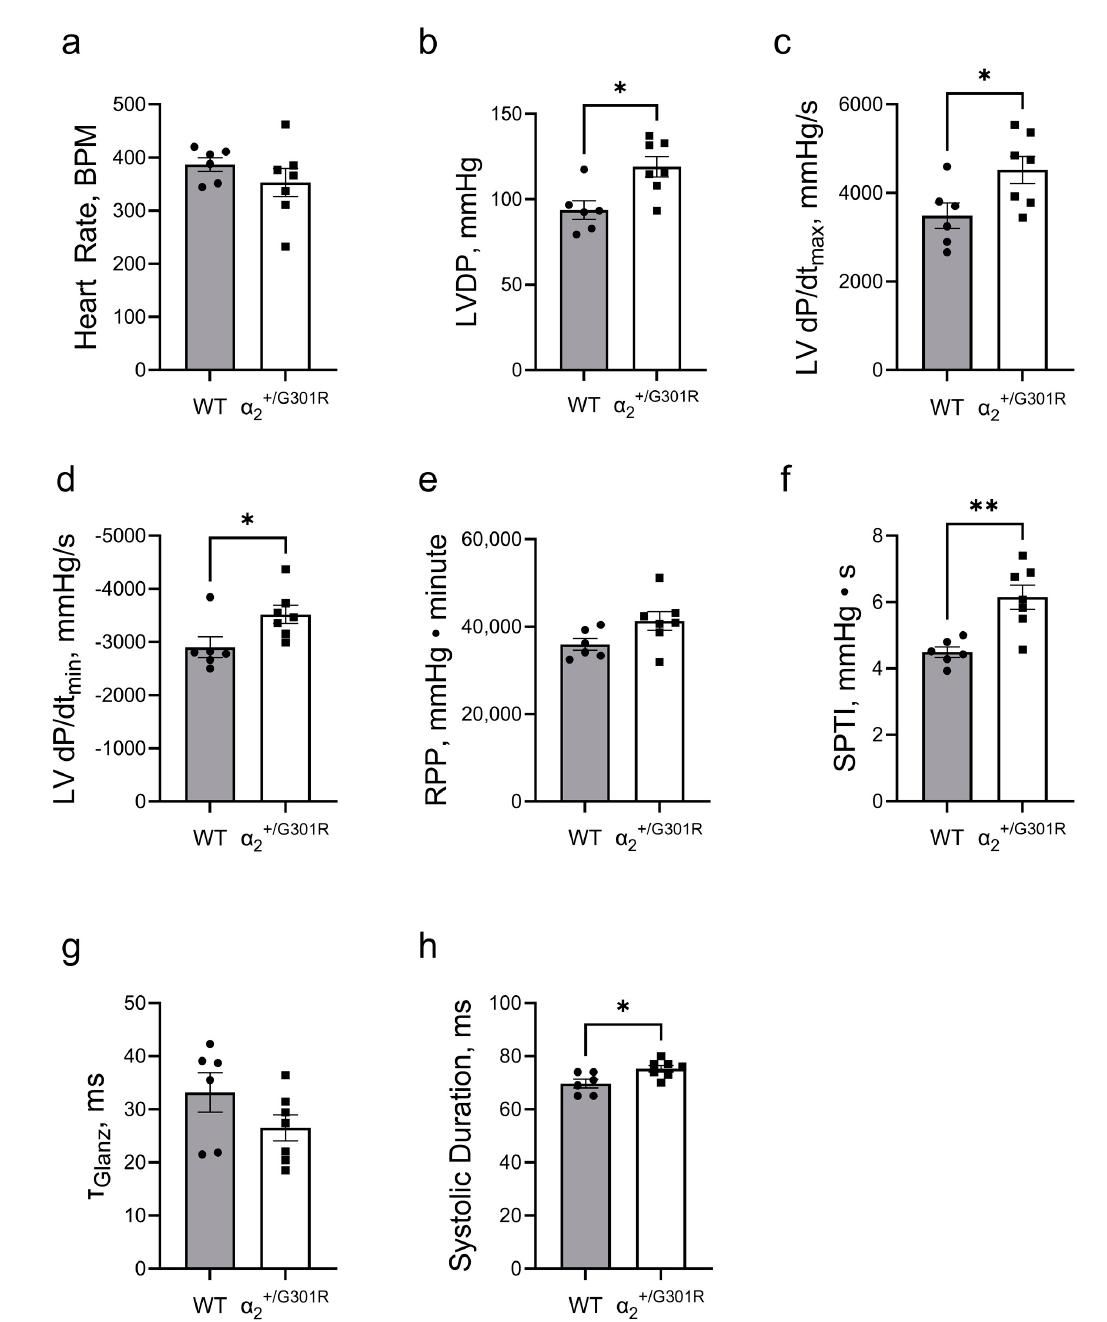
Figure 3. Isolated hearts from α 2+/G301R mice exhibited greater cardiac contractility and increased systolic work during sinus rhythm . ( a ) Heart rate was similar between WT and α 2+/G301R hearts. ( b ) Left-ventricular-developed pressure (LVDP) and ( c ) left ventricular dP/dt max (LV dP/dt max ) were greater for α 2+/G301R hearts than for WT hearts. ( d ) Left ventricular dP/dt min (LV dP/dt min ) was more negative for α 2+/G301R hearts than for WT hearts. ( e ) The rate–pressure product (RPP) was not different between the two genotypes, but ( f ) the systolic pressure–time index (SPTI) was larger in +/G301R hearts than in WT hearts. ( g ) τ α 2 Glanz was not different between the two groups, but ( h ) the systolic duration was longer for α 2 +/G301R hearts. Data were compared with an unpaired t -test or a Mann–Whitney test. * p < 0.05 and ** p < 0.01; wild type vs. α 2 +/G301R . n =